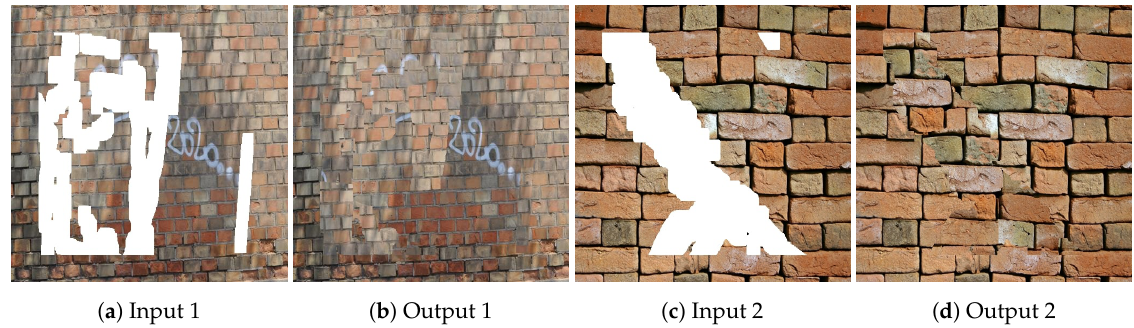
Figure 2. Patch-based technique [34] results for two wall samples, ( a , c ) inputs photos with holes that